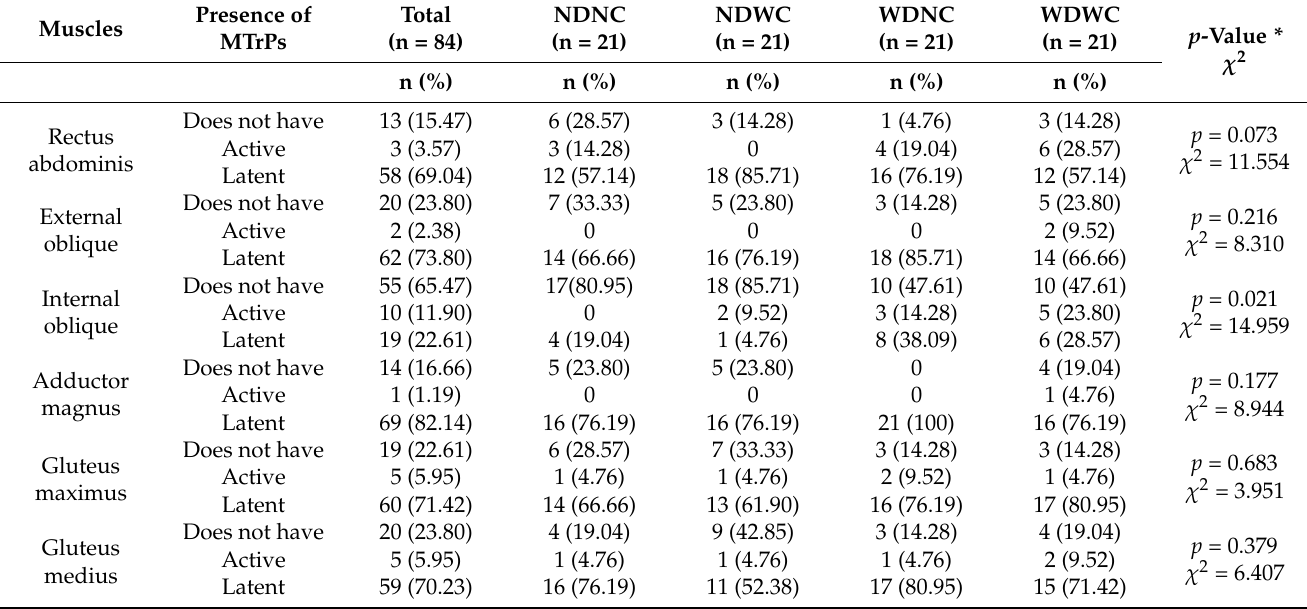
Table 7. Presence of MTrPs in the external muscles evaluated in the ovulatory